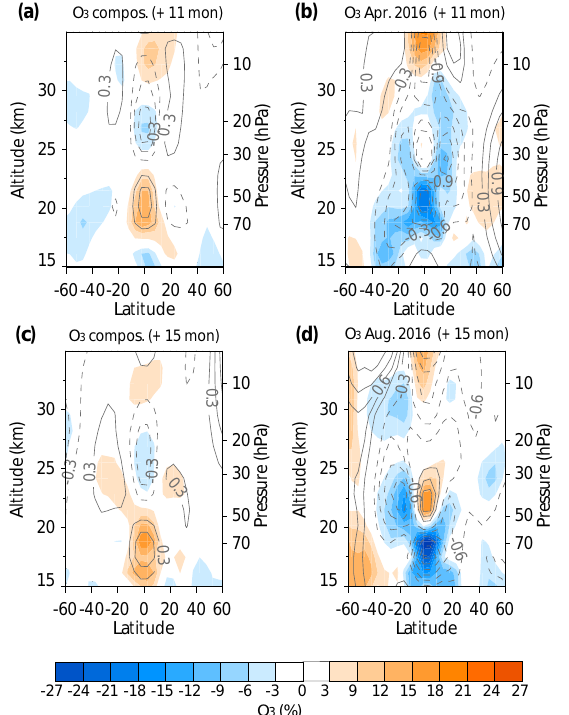
Figure 4. Latitude–height cross sections of deseasonalized MLS ozone (filled) and temperature (gray contours) in the composite (a) 11 and (c) 15 months after the wind shear reversal based on four QBO cycles and during (b) April ( + 11 months) and (d) August 2016 ( + 15 months). Ozone and temperature values are shown in percent change from long-term monthly averages with contour in- tervals every 3 and 0.3%, respectively (zero contour is omitted).